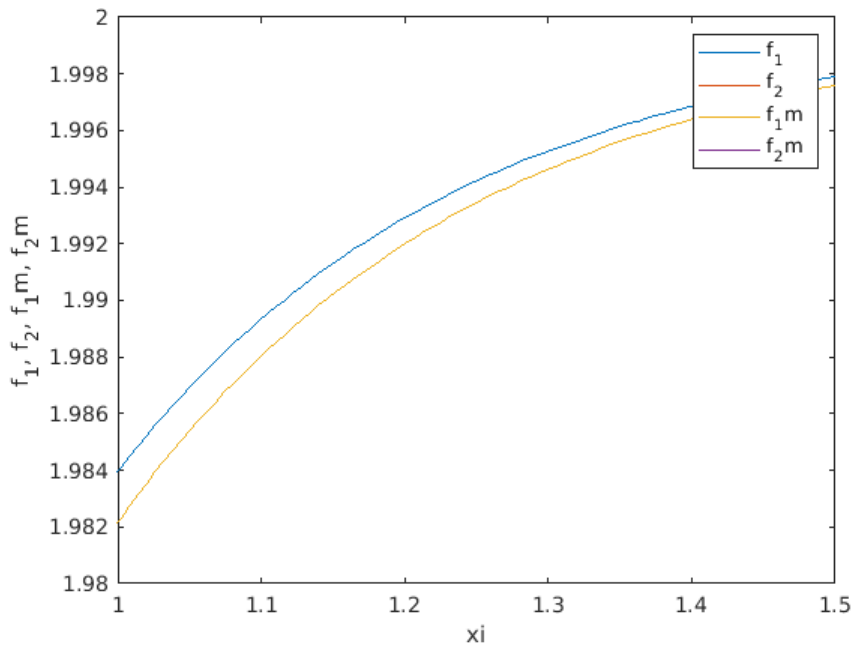
Figure 5. TW profiles for a + λ = 4 with n = 0.2, m = 0.9. Note that the solution to (20) is represented by f 1 m in the